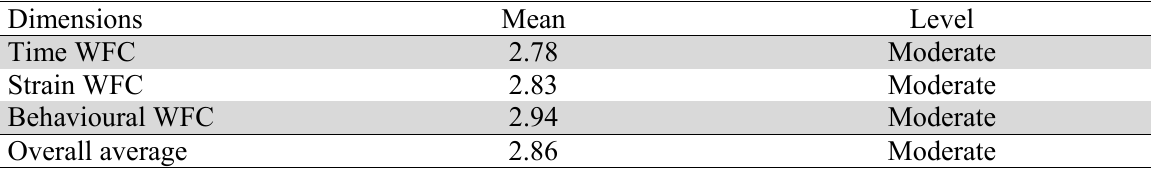
Summary of mean dimension